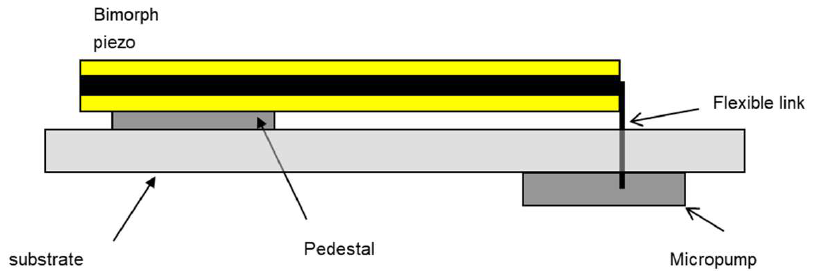
Figure 6. Sketch of the “mechanical loop” with the pedestal, the piezo, the flexible link, the micropump chip, and the substrate.